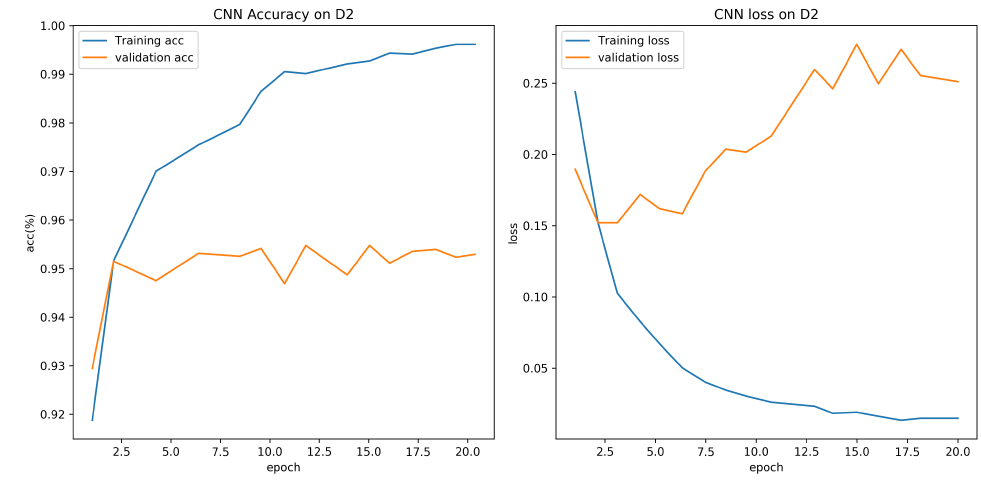
Figure 7. Evaluation on D1 with CNN.